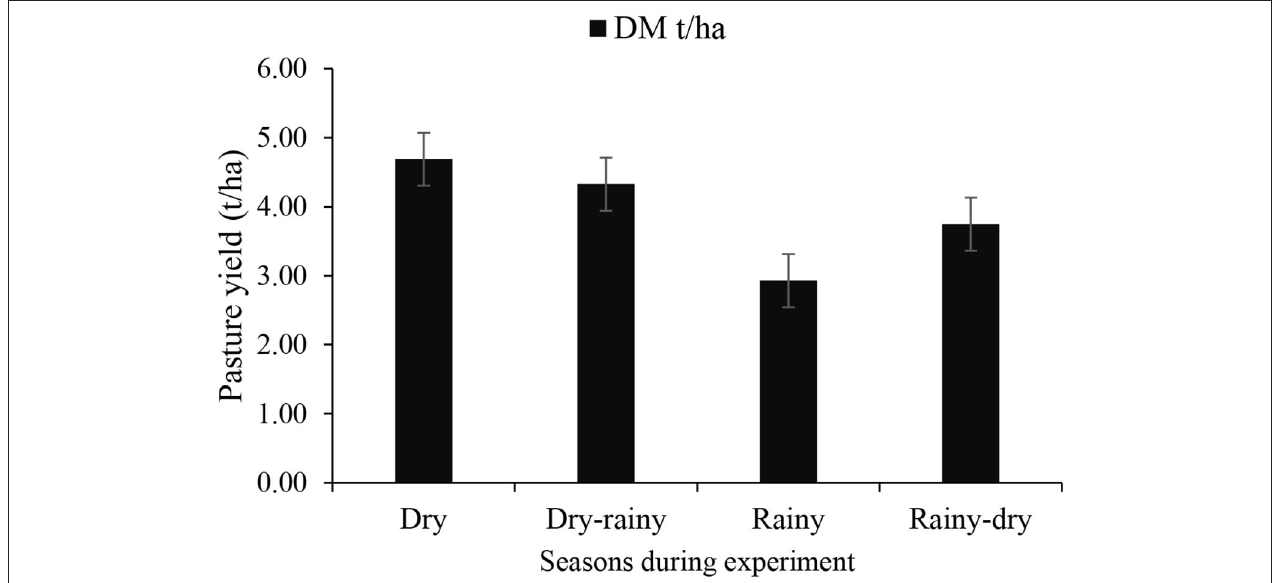
FIGURE 1 | Pasture yield during experiment period per season. Dry season, August (beginning of the experiment); dry, rainy transition, September to November, rainy season, December to February; rainy–dry transition, March to June (end of the experiment). DM, dry matter; t/ha, ton per